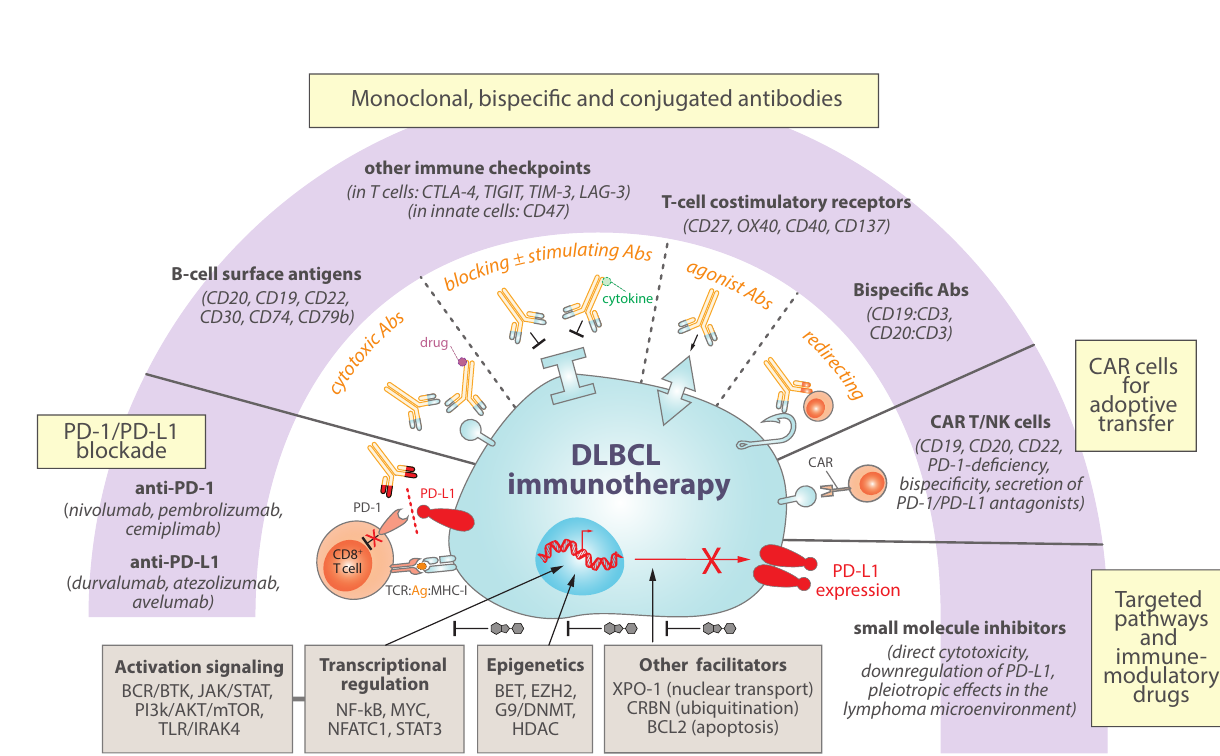
Figure 3. Immunotherapy strategies for DLBCL with promising rationale to involve or cooperate with PD-1/PD-L1 block- ade. Combinational immunotherapy offers a potential to improve the current limited therapeutic efficacy of PD-1/PD-L1 blockade in DLBCL. For example, exploring novel monoclonal, bispecific or conjugated antibodies might cooperate to target a continuously extending portfolio of B-cell specific and tumour antigens, to block other immune-checkpoint in- hibitors, to enhance immune stimulation by cytokine delivery or T-cell costimulatory receptor targeting, or to strategically redirect T cells trying to enhance anti-tumour engagements. Adoptive transfer therapies of T or NK cells with rapidly evolving new generations of engineered chimeric antigen receptors (CAR) are also emerging as promising alternatives to DLBCL patients. Finally, and profoundly connected with precision medicine for DLBCL patients, a plethora of small molecule inhibitors to key DLBCL deregulated pathways is continuously being investigated with the goal of inducing direct cytotoxicity of lymphoma cells. Interestingly, most of these targeted pathways are intertwined with PD-L1 reg- ulation and might offer concomitant opportunities as immune-modulatory drugs, further offering promising clinical synergistic